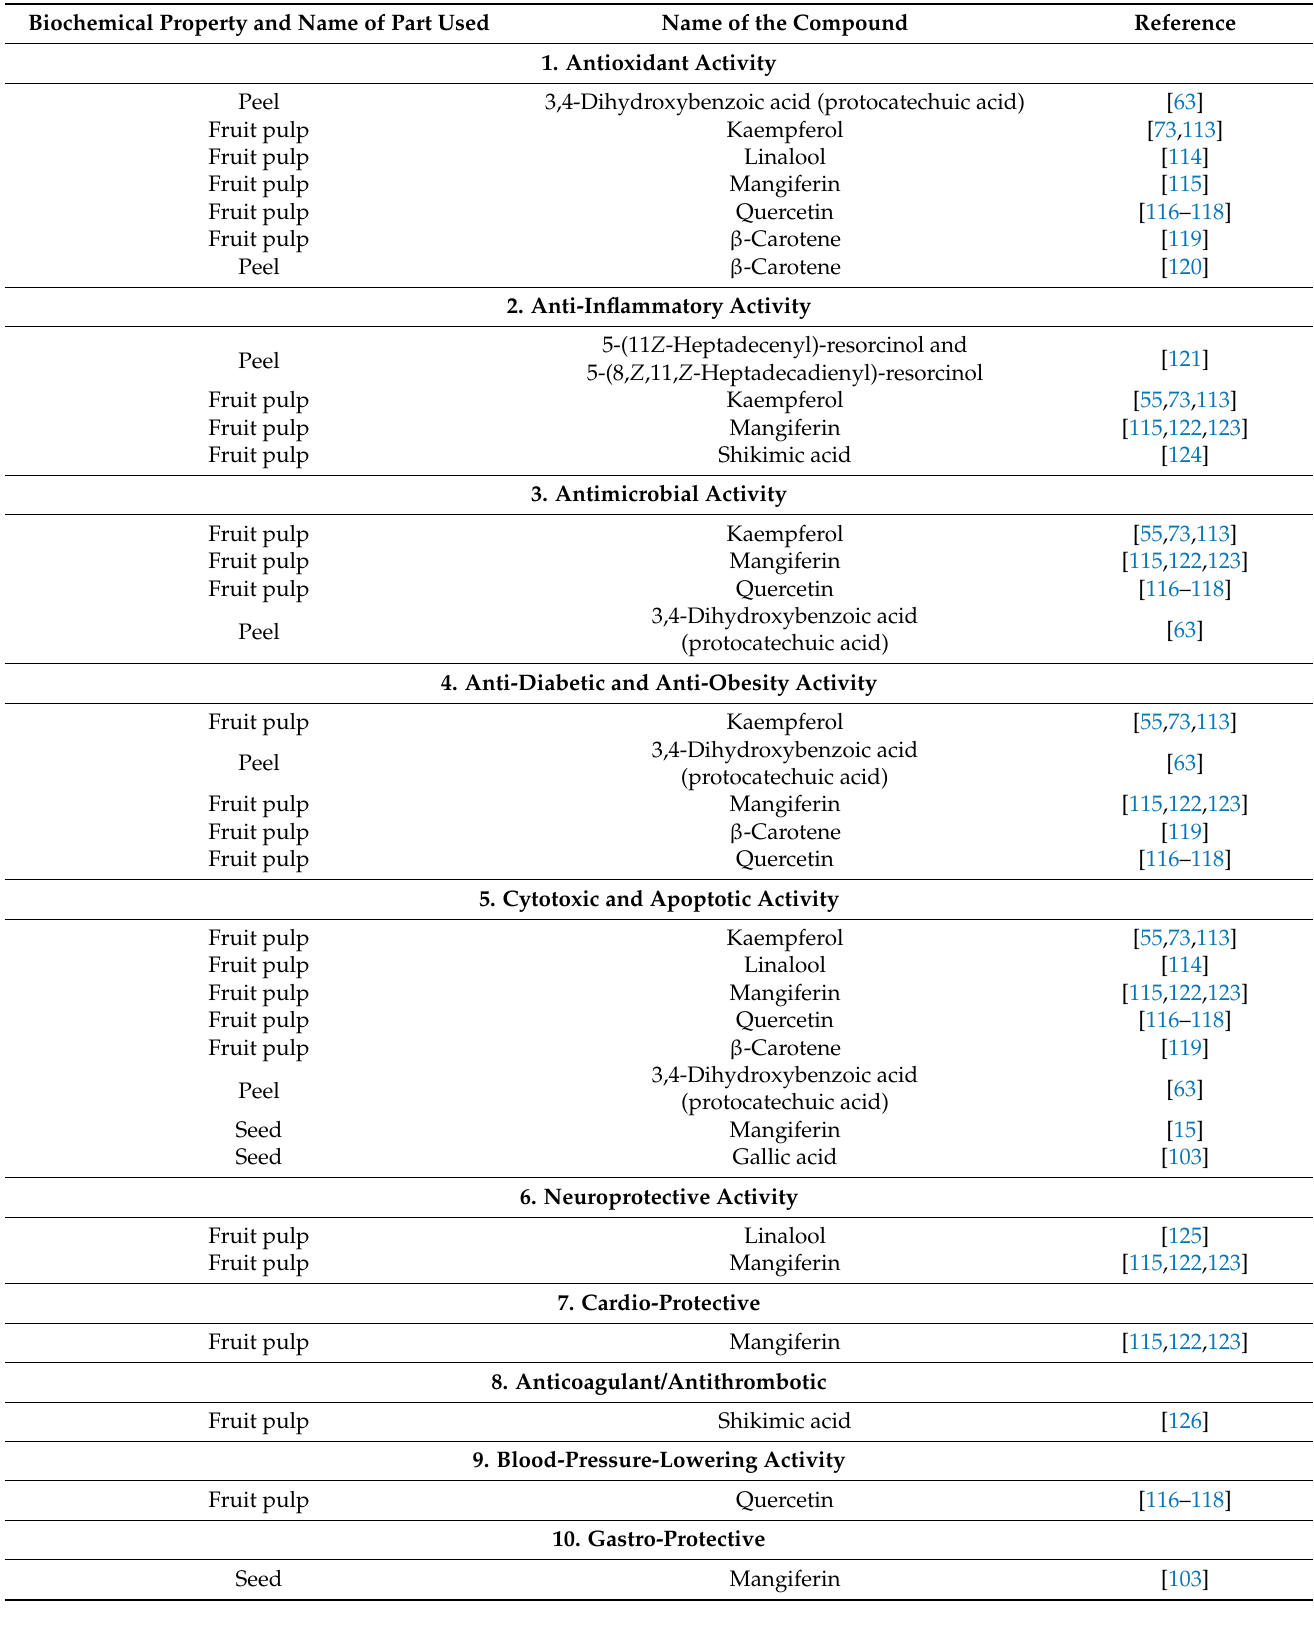
Table 3. Biological activities of phytochemicals isolated from M. indica